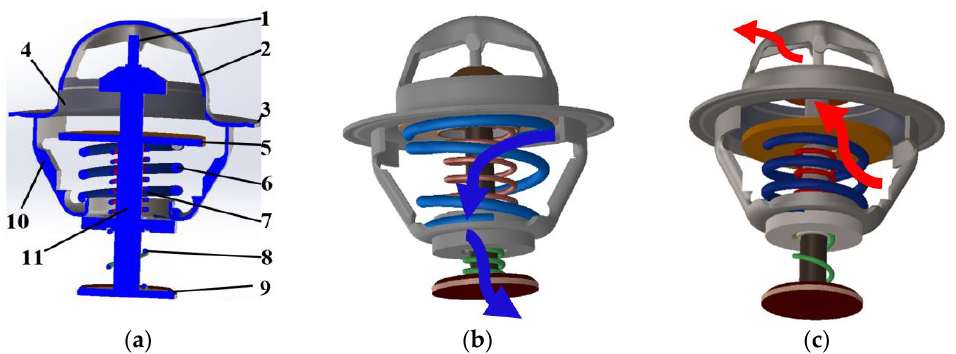
Figure 4. Schematic of SMA-based thermostat. ( a ) Components of the SMA-based thermostat: (1) thrust pin, (2) bridge, (3) flange, (4) valve seat, (5) main valve piston, (6) bias spring, (7) SMA spring, (8) bypass spring, (9) bypass valve piston, (10) frame, and (11) rod. ( b ) Closed thermostat (the blue arrows represent the coolant flow direction when the thermostat is closed). ( c ) Open thermostat (the red arrows indicate coolant flow once the thermostat is opened).